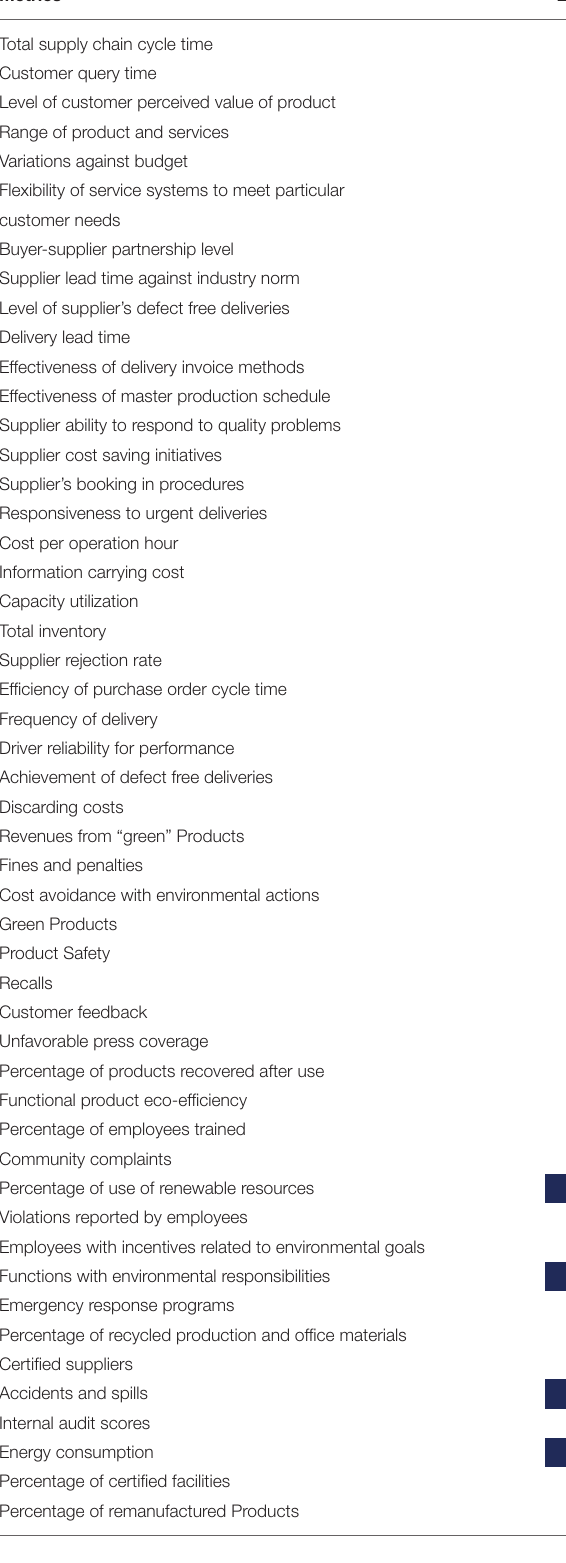
TABLE 9 | Insertion of metrics in the dimensions of TBL and in the transversal dimension.